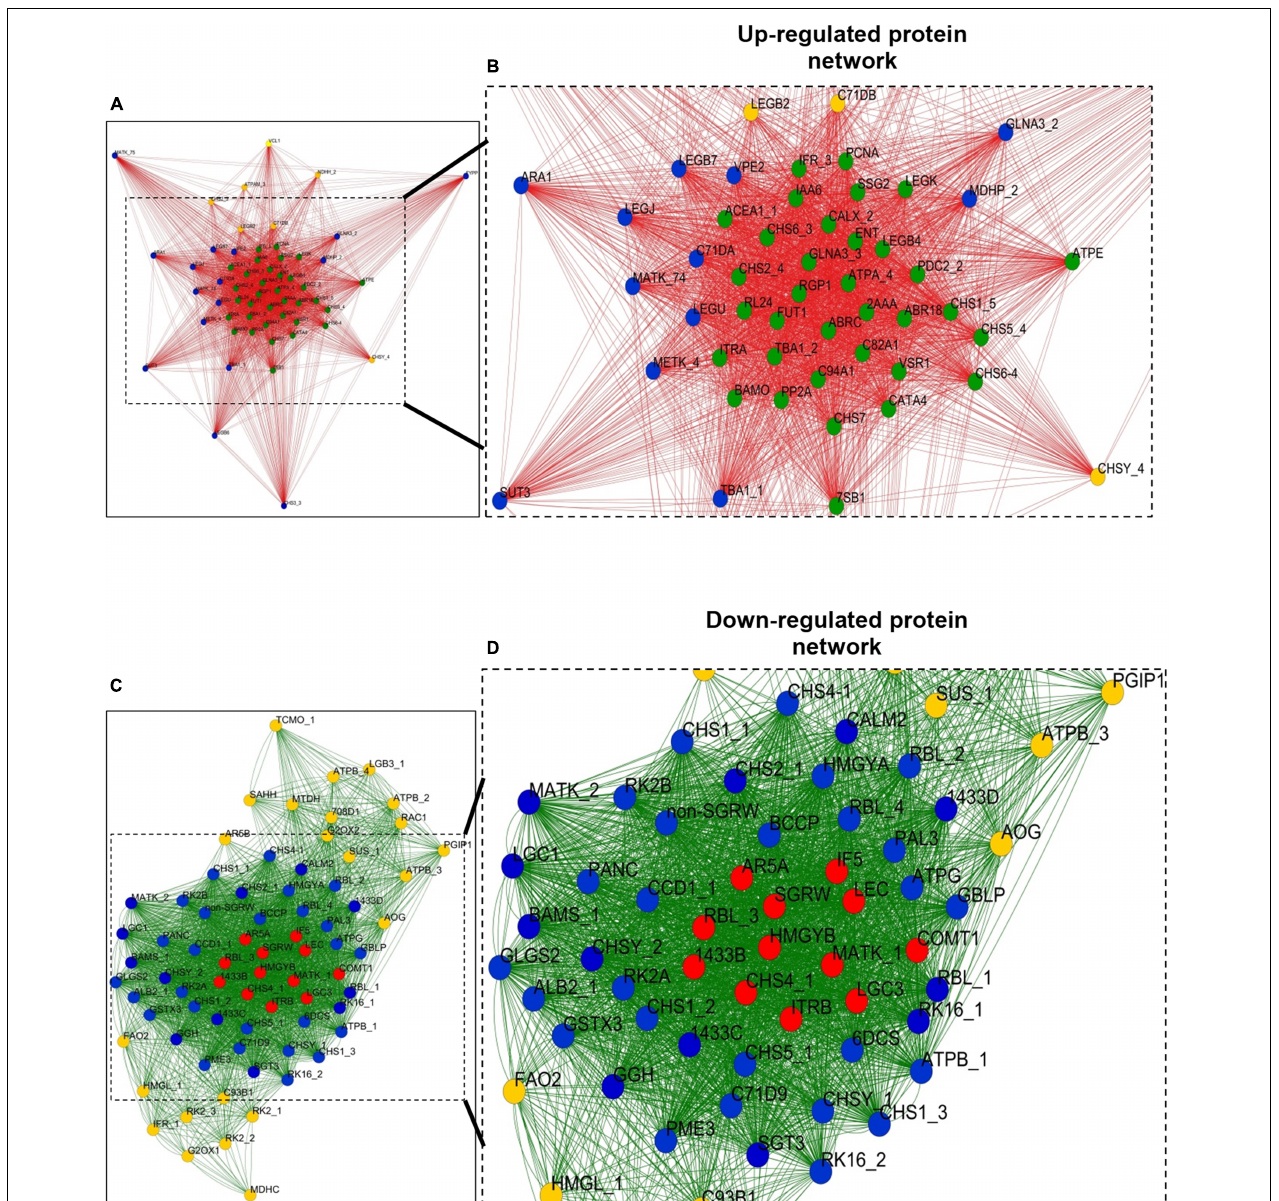
FIGURE 7 | Correlation networks of abundant proteins. (A) Correlation network of HAPs based on Pearson correlation coefficient with probability threshold P < 0.0001. Each node was represented with a different color based on the degree of interaction. The order of interaction was green color node > blue color node > yellow color node. (B) Correlation network of 53 protein species in a cluster; box was drawn to represent zoom-in of the most highly interconnected core of proteins. (C) Correlation network of LAPs based on Pearson correlation coefficient with probability threshold P < 0.0001. Each node was represented with a different color based on the degree of interaction. The order of interaction was red color node > blue color node > yellow color node. (D) Correlation network of 72 protein species in a cluster; box was drawn to represent zoom-in of the most highly interconnected core of proteins. For protein abbreviations,